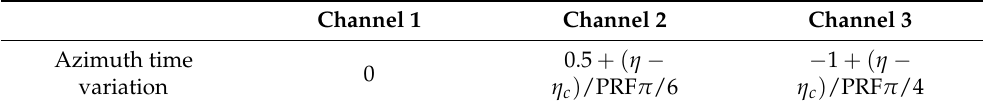
Table 6. Linear phase error setting of azimuth.